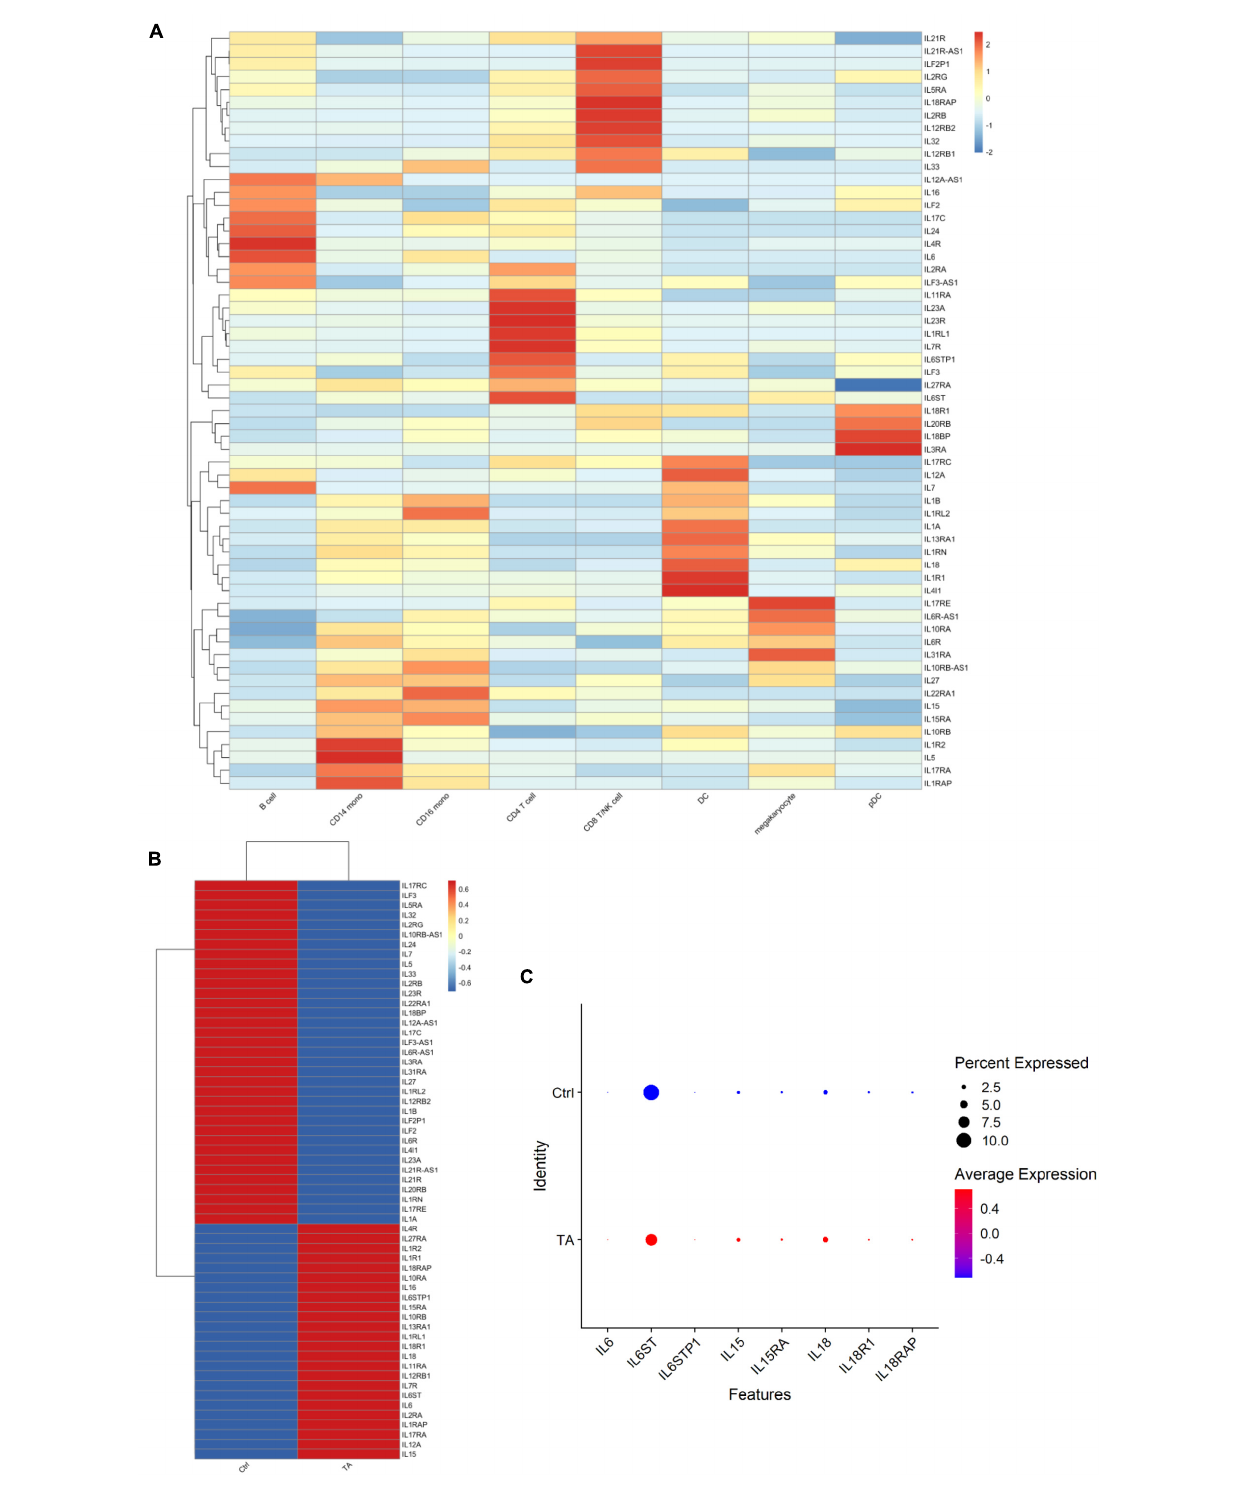
FIGURE 4 | (A) The expression of ILs in each cell type. (B) The expression of ILs in TA and Ctrl group. (C) Dotplot of 8 IL genes. It can be found IL-6, IL-6STP1, IL-6ST, IL-15, IL-15RA, IL-18, IL-18RAP, and IL-18R1 were detected in TA group.